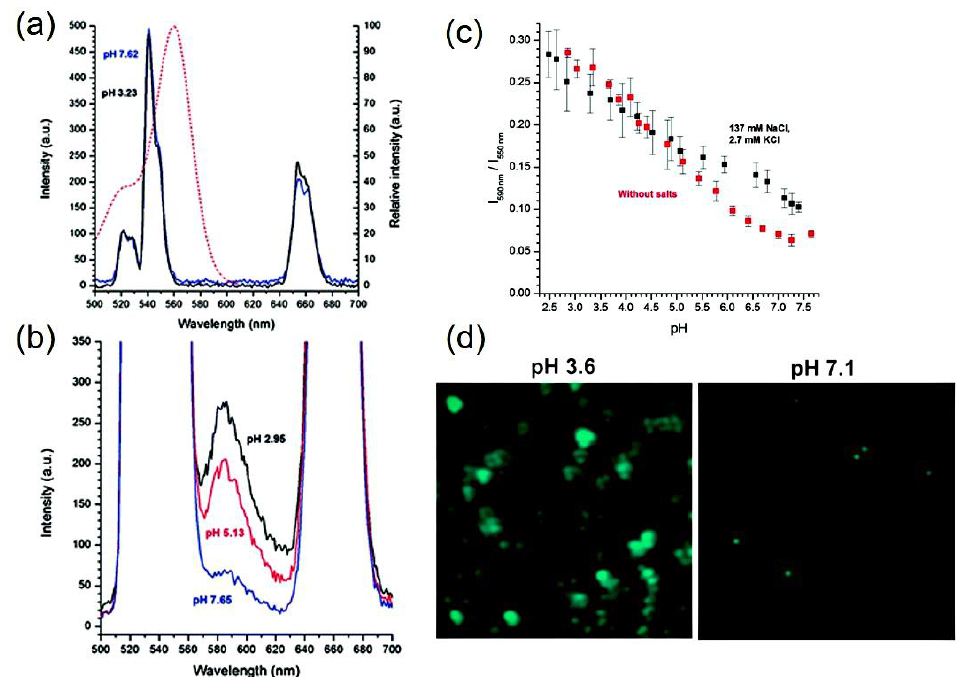
Figure 6. ( a ) Upconversion luminescence spectrum of dye conjugated-UCNPs in pH 7.62 and 3.23. The excitation spectrum of pHrodo™ Red (red dots, right y -axis) is overlapped with the upconversion emission spectrum. ( b ) Upconversion-sensitized luminescence emission spectrum of pHrodo™ Red in pH 7.65, 5.13 and 2.95. ( c ) Ratio of intensities of the sensitized luminescence emission of pHrodo™ Red at 590 nm and the upconversion emission at 550 nm with (black) and without (red) a physiological salt concentration. ( d ) Fluorescence microscopy images of the green luminescence of pHrodo™-conjugated-UCNPs at different pHs (Reproduced from Ref. [85] with permission from The Royal Society of